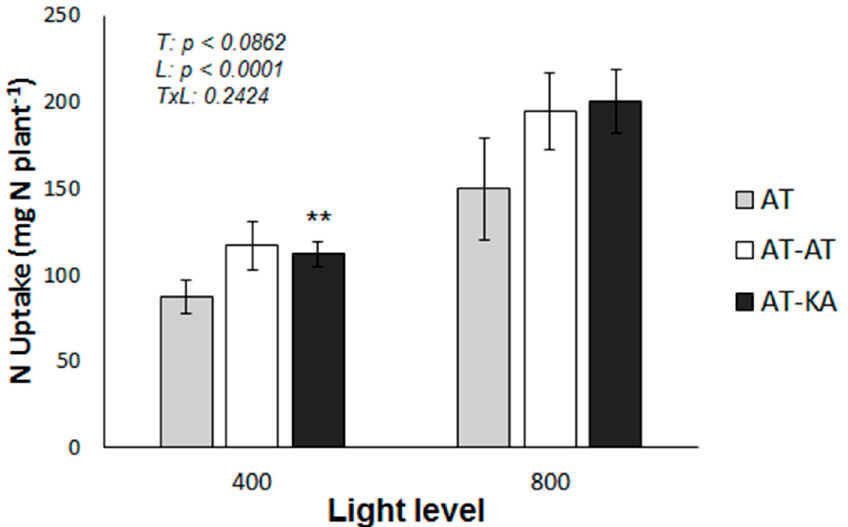
Figure 2. Total plant N uptake in each treatment under medium (400 µ mol m − 2 s − 1 ) or high (800 µ mol m − 2 s − 1 ) radiation during a 30-day period. Bars represent mean ± SE of eight replicates. p -Values for treatment ( T ), light ( L ) and the interaction ( TxL ) effects are included. Asterisks indicate the significance level ( **: p < 0.01) for the differences in the same treatment across light levels. AT: Non-grafted treatment; AT-AT: Homograft; and, AT-KA: Graft treatment. Grafting significantly reduced shoot N content ( p < 0.0296) under medium light intensity, whereas no differences were found under high radiation ( p < 0.1211) (Table 1). Root N content was not affected by the treatments ( p < 0.6704) or light level ( p < 0.2836), with an average value of 43.1 ± 2.1 mg N g − 1 dry weight